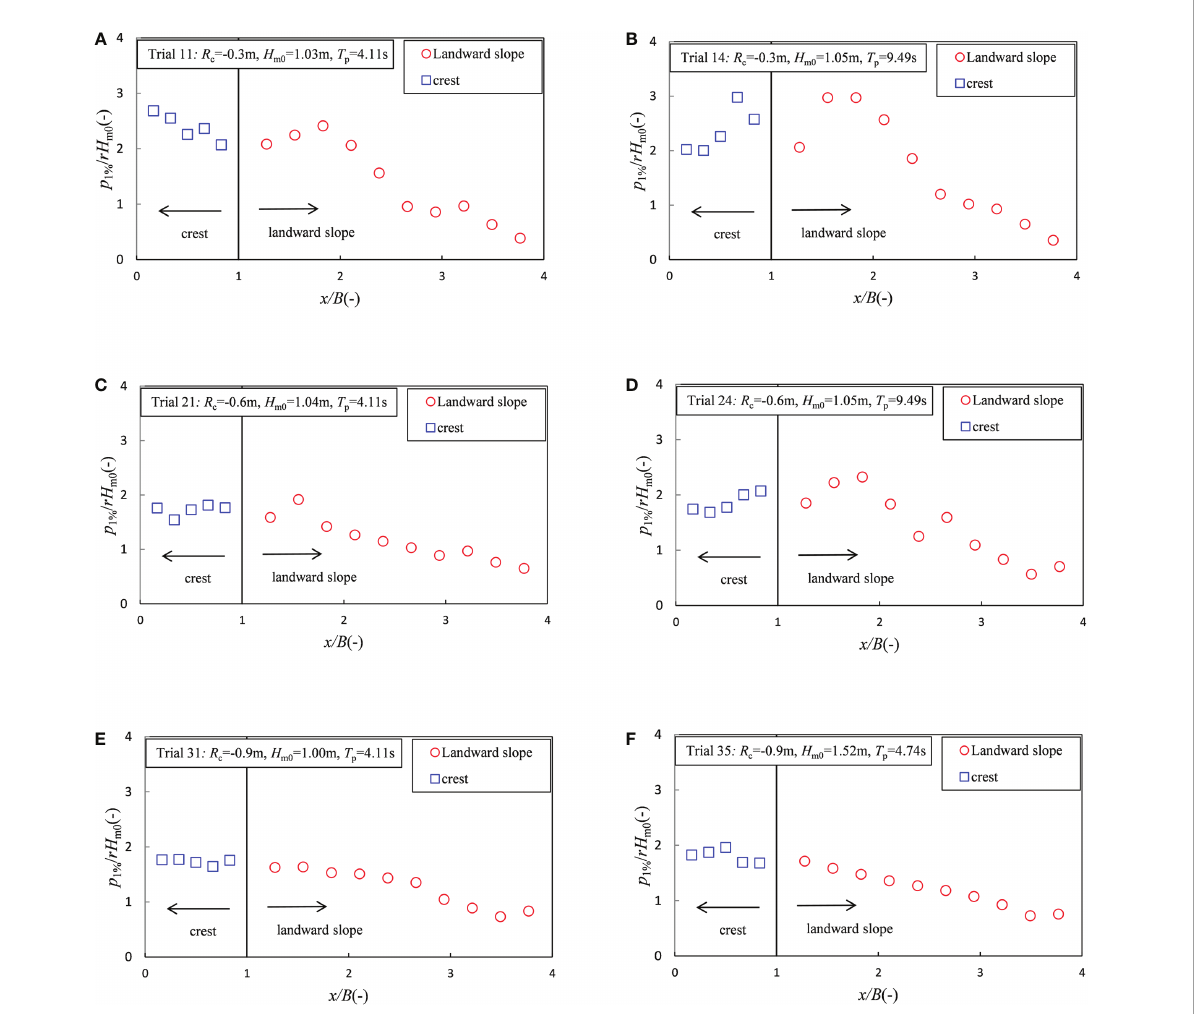
FIGURE 8 Spatial distribution of the relative normal stress along the dike. (A) Small wave period ( R c = − 0.3m). (B) Large wave period ( R c = − 0.3m). (C) Small wave period ( R c = − 0.6m). (D) Large wave period ( R c = − 0.6m). (E) Small wave height ( R c = − 0.9m). (F) Large wave height ( R c = −